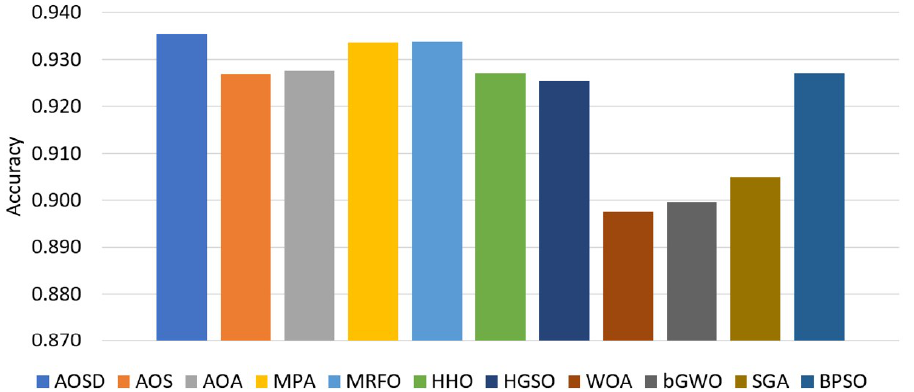
Figure 3. Average of the classification accuracy among tested